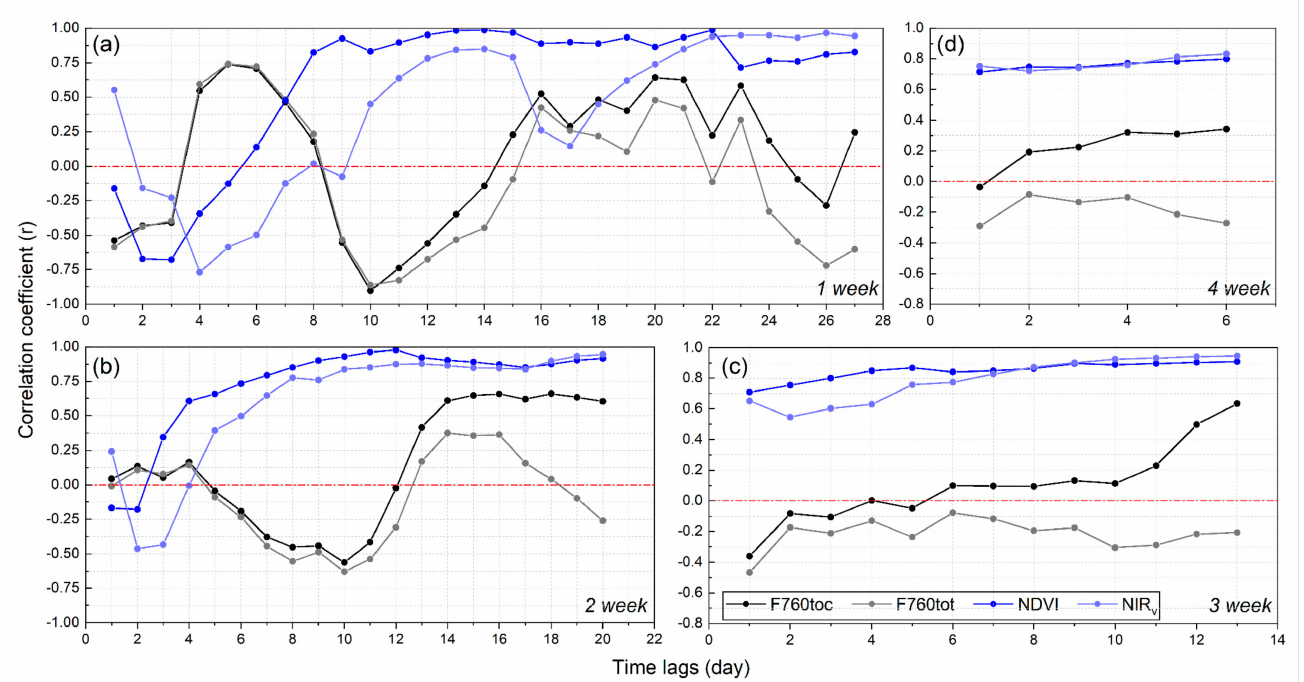
Figure 11. Correlations between F760toc, F760tot, NDVI, NIR v , and soil moisture in 20-cm soil layer from P4 with different time windows in time lags of ( a ) 1 week, ( b ) 2 weeks, ( c ) 3 weeks, and ( d ) 4 weeks. Note that 1–4 weeks represents the temporal resolution of data. The horizontal axis represents the number of days that soil moisture precedes SIF or VIs. Each datum represents the daily mean value of the